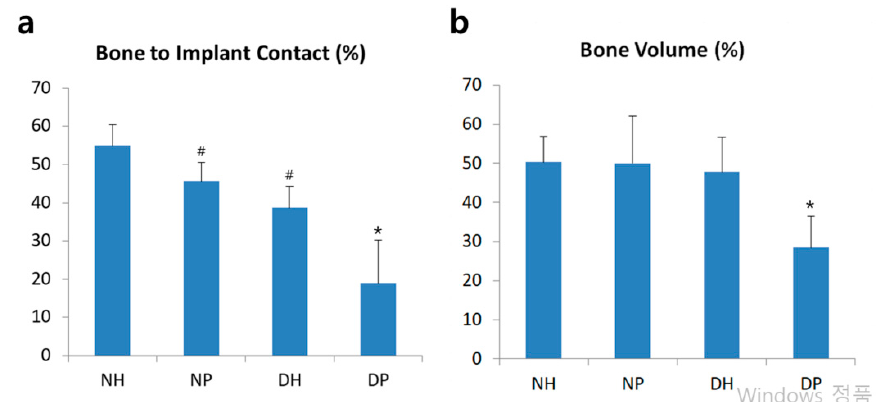
Figure 2. Histomorphometric analysis. ( a ): Linear percentage of direct BIC in the total surface of implants. ( b ): Percentage of newly formed bone area in the circumferential zone within 100 µ m of the implant surface. Data represent mean ± SD. *: p -value < 0.05 vs all other groups; #: p < 0.05 vs NH